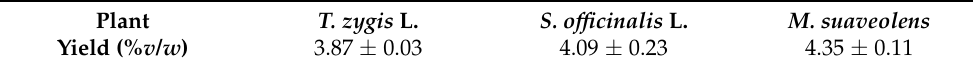
Table 1. Yields of essential oils extracted from the studied plants. Plant